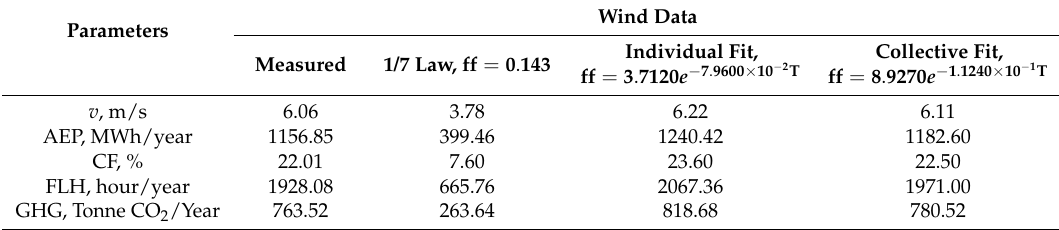
Table 8. Wind resource and energy yield parameters calculated at 70 m by the Kudat site using a single 600-kW rated power Dewind D4/48-600 wind